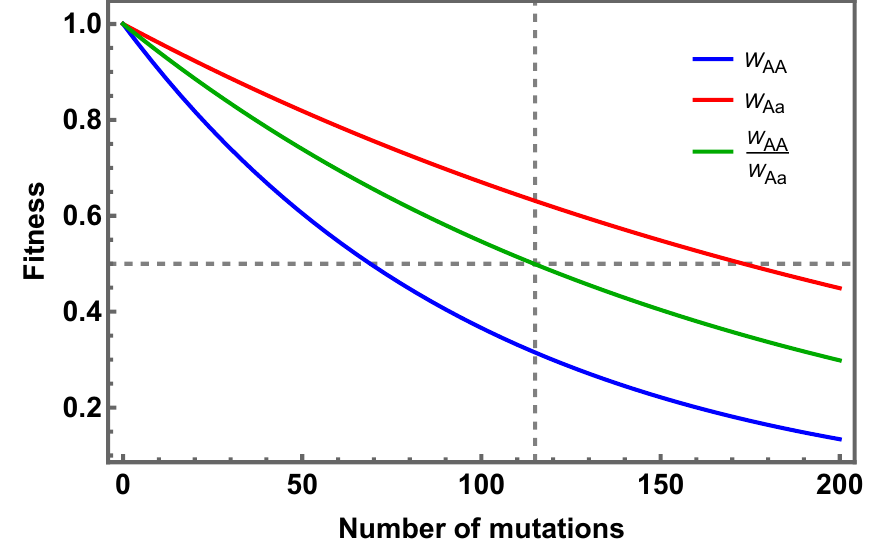
Figure S1 – Declines in homozygote (AA) and heterozygote (Aa) fitness and the fitness of homozygotes relative to heterozygotes as a function of the number of completely linked mutations expressing pseudo-overdominance. Mutations are identical, slight ( s = 0.01 ), recessive (dominance h = 0.2 ), and have independent (multiplicative) fitness effects. s ) n while heterozygote fitness is (1 hs ) 2 n (see Eqs. Homozygote fitness is given by (1 − − 2 and 3 in the main text). The horizontal dashed line shows the threshold fitness at which homozygote fitness drops to less than half the fitness of the heterozygote - a condition for POD indefinite persistence even in fully selfing populations. For these parameter values, this occurs for n = 115 (the vertical dashed line). (cf. Supp. File 1 Fig.